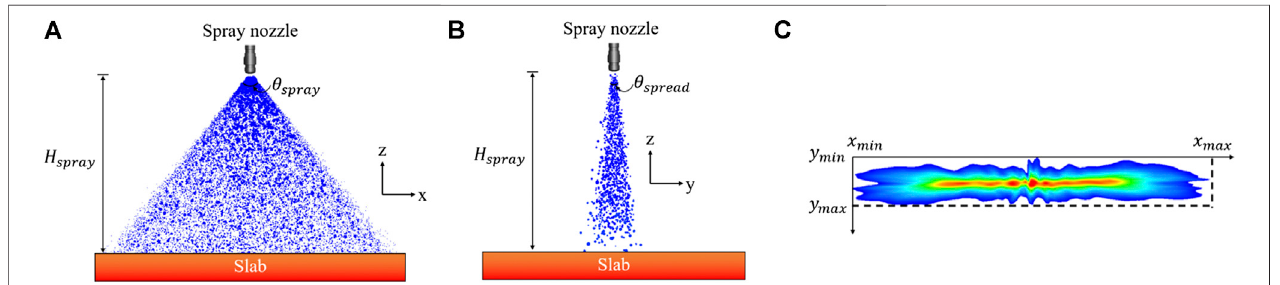
FIGURE 12 | Calculation of HTC coverage on the steel surface (A) casting direction, (B) transverse direction, and (C) top view of HTC pattern.